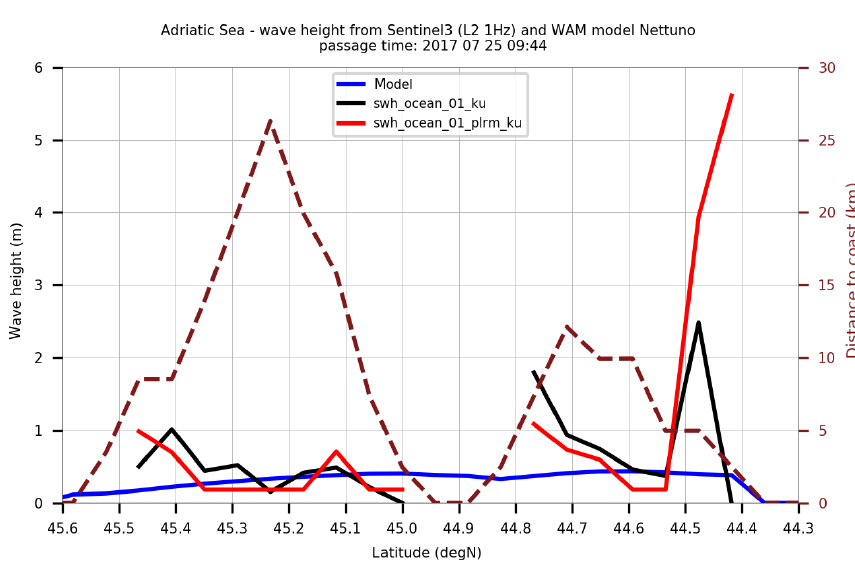
Figure 8. Inter-comparison, for the pass shown in Fig. 6 and the time shown in Fig. 7, of the S3 ku- and plrm-ku- wave heights and the corresponding wave model results. The dashed line shows the distance from the closest coast (in kilometres).